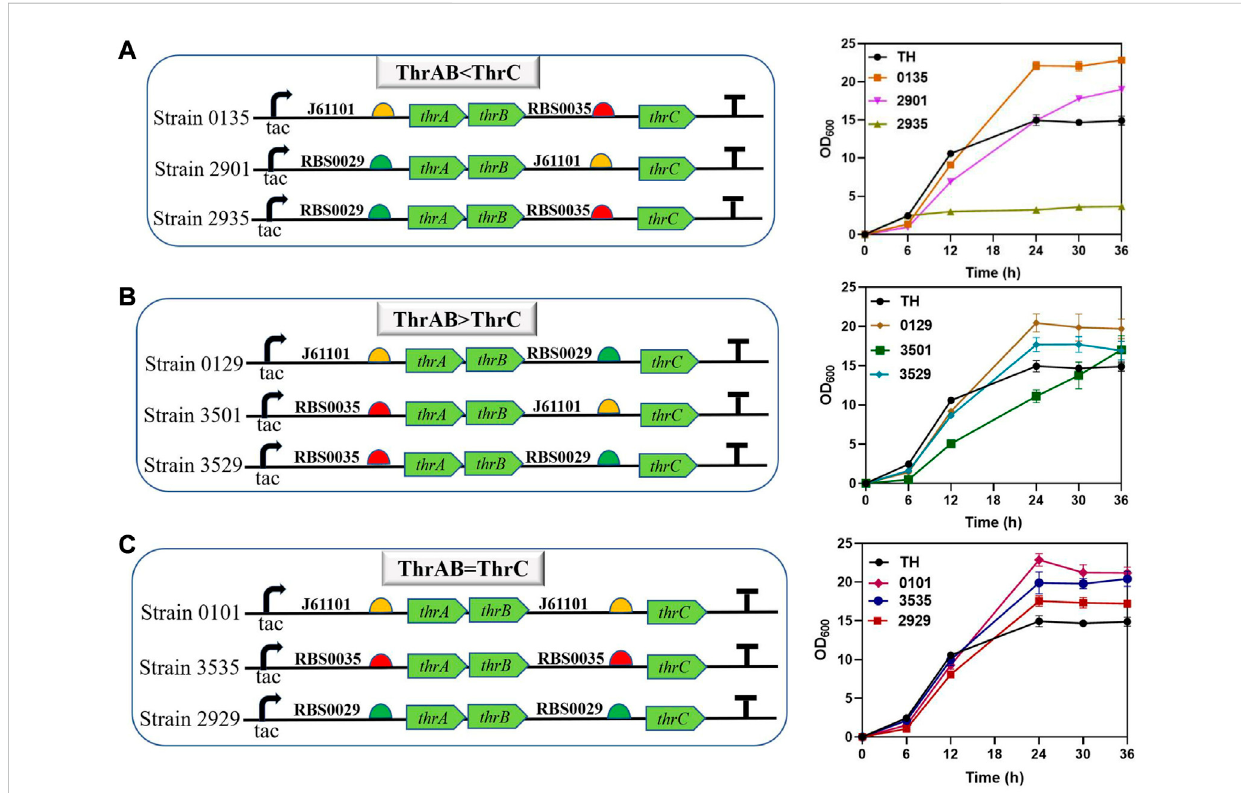
The effect of differentexpression intensities of thrAB and thrC on strain TH growth. According to the RBS strength, theadjusted expression of thrAB and thrC was classi fi ed into three groups: ThrAB < ThrC, ThrAB > ThrC and ThrAB = ThrC. All results were calculated from three ( n = 3) independent repeats. (A) Strains with thrAB expression weaker than thrC were constructed using different combinations of RBS, and fermentation results OD 600 are shown. (B) Strains with thrAB expression stronger than thrC were constructed by using different combinations of RBS, and fermentation results